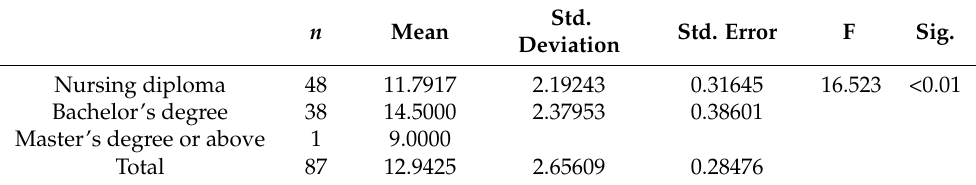
Table 5. Educational level of participants ( n = 87).